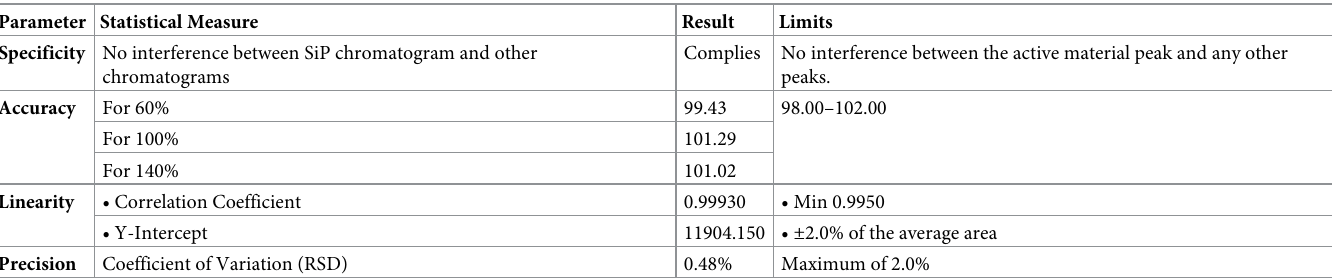
Table 4. Summary results of the validation of the assay of SiP solution.